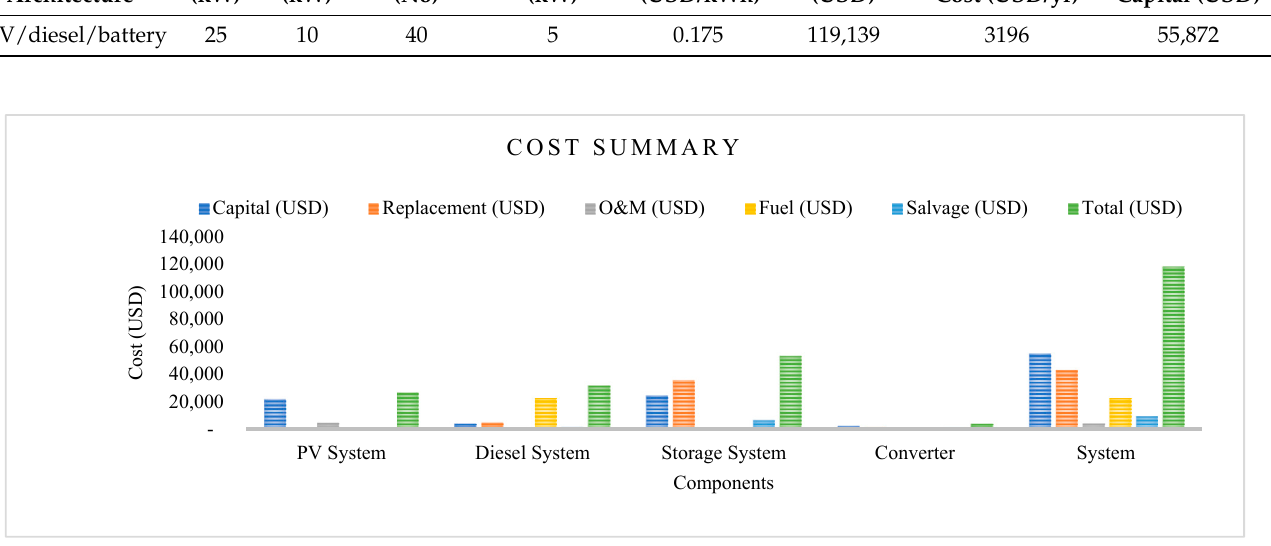
Figure 11. Cost summary of PV/diesel/battery system components. Table 4. Simulation result of optimal minigrid system, architecture, and cost.